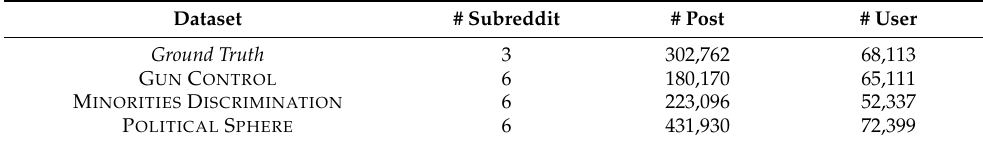
Table 2. Description of the